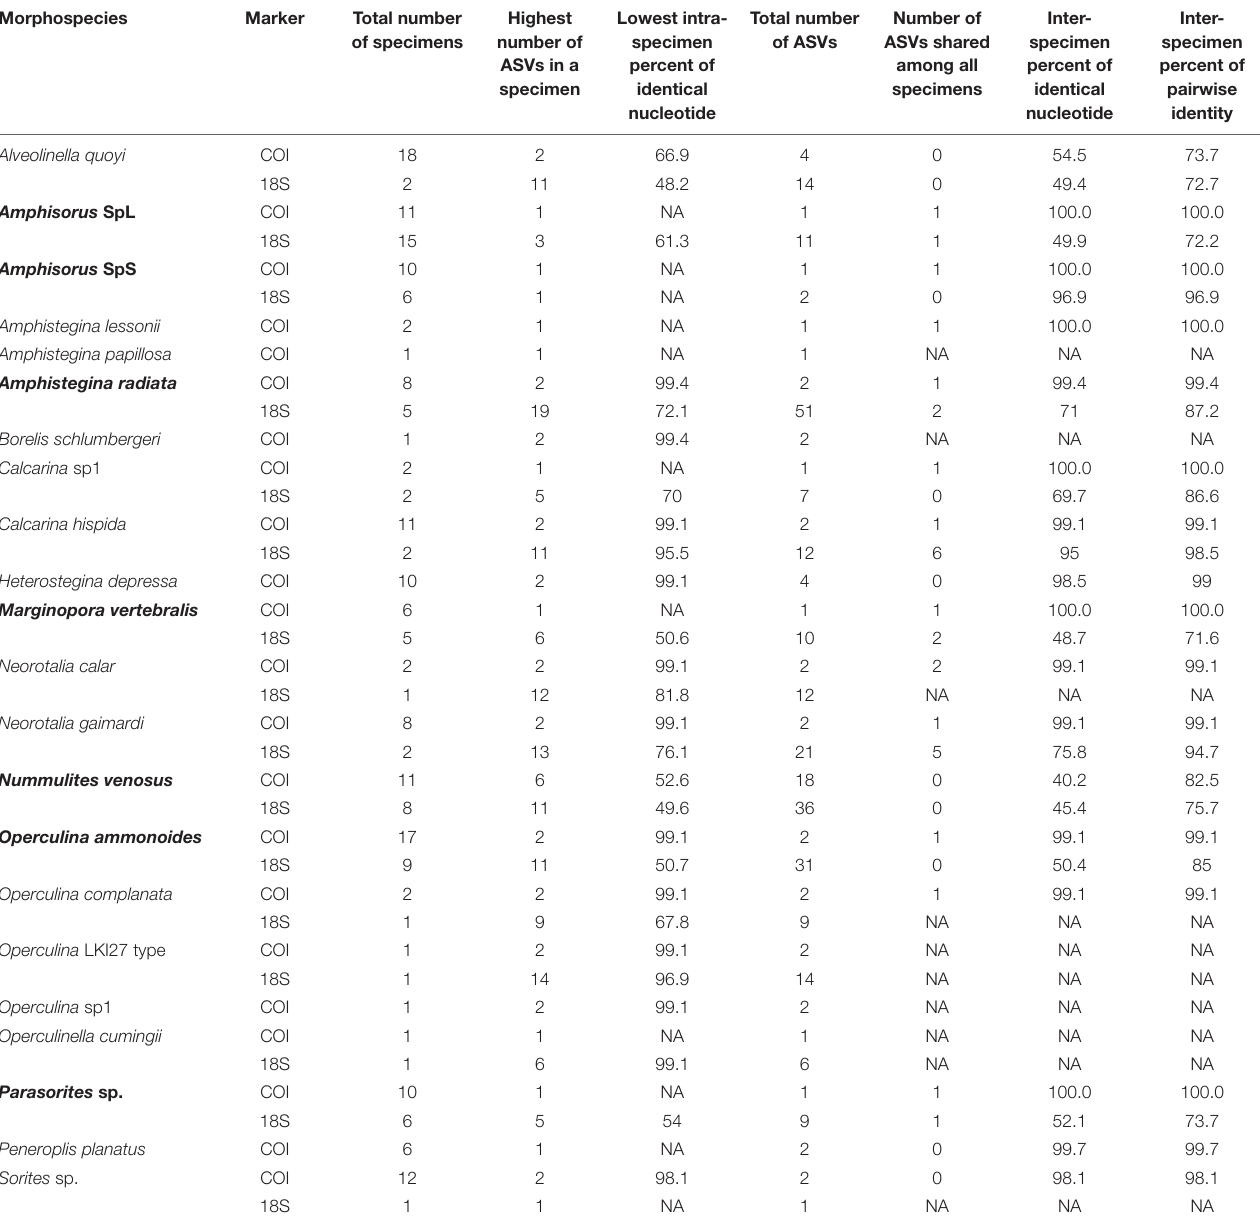
TABLE 3 | Species genetic variability, intra-specimen and inter-specimen. Morphospecies Marker Total number